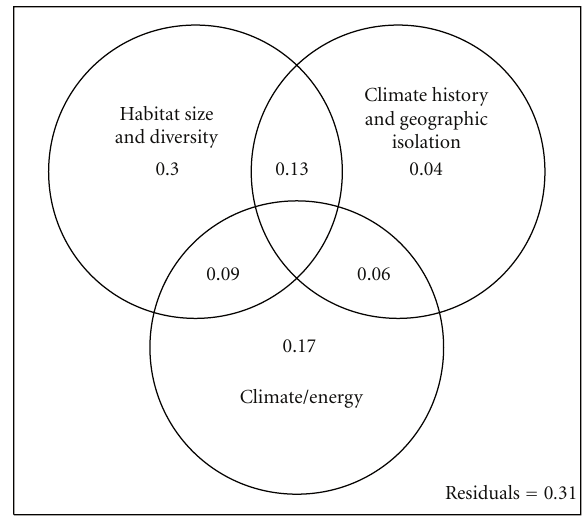
Figure 3: Variance partitioning in explaining species richness gradients between area-related, climate-related, and historical variables. The analysis was performed using the “varpart” function from the vegan R package [64] and grouping variables as in Table 1.